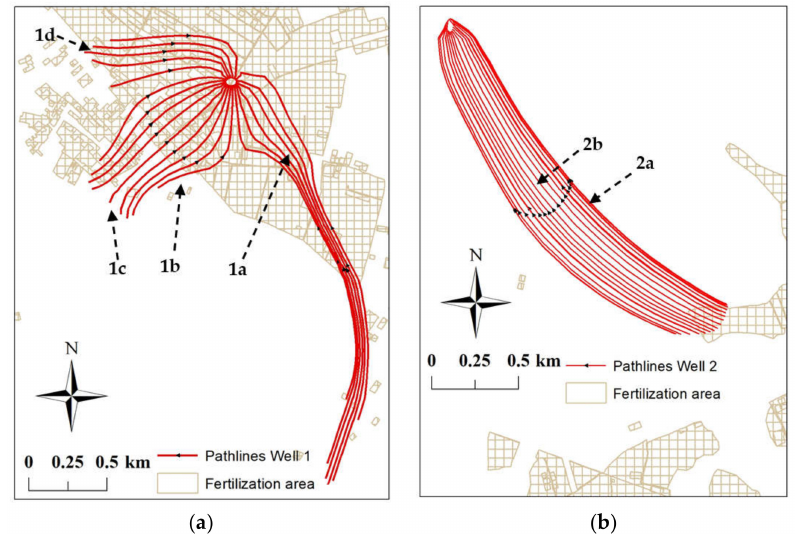
Figure 11. The groundwater path lines for two selected wells in the Eocene aquifer. ( a ) Well 1 and ( b ) Well